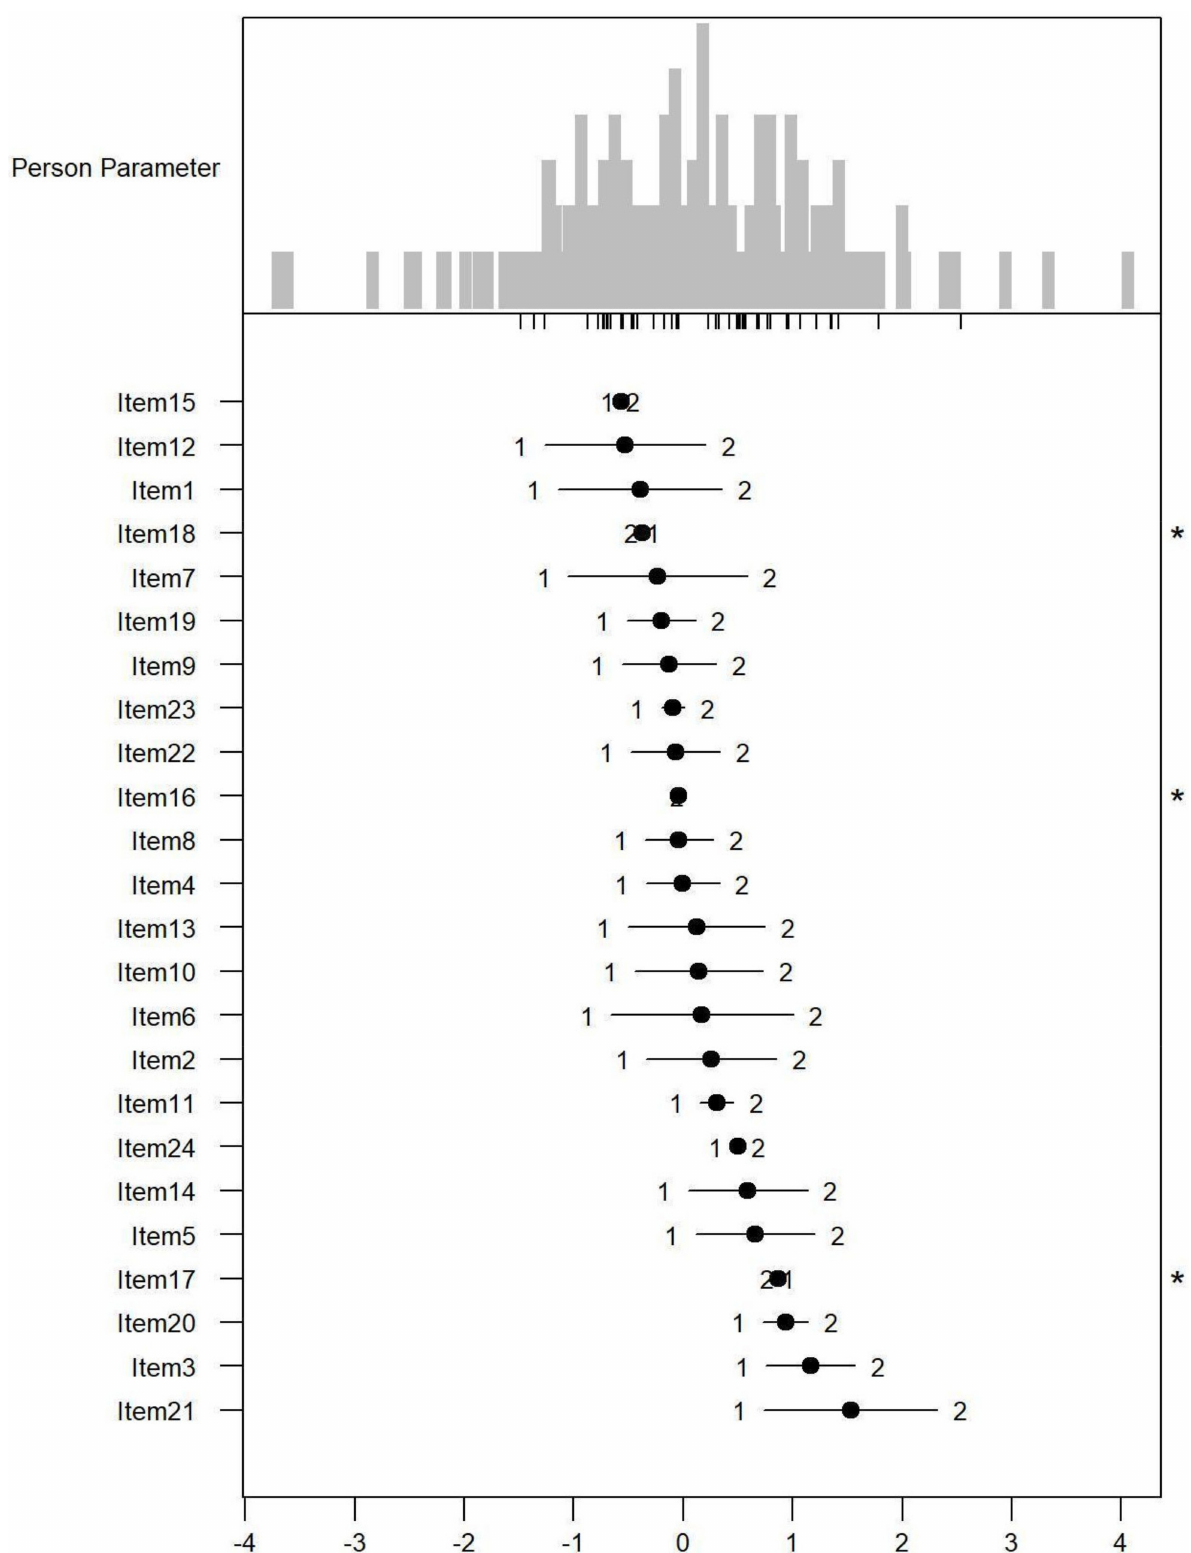
Figure 1. Person-item map for the person parameter and item parameter distribution of the 24 Par- adise items having response categories (1 = none, 2 = mild to moderate, and 3 = severe to extreme PSDs). * Disordered thresholds are flagged by means of a ‘*’ in the margin of the